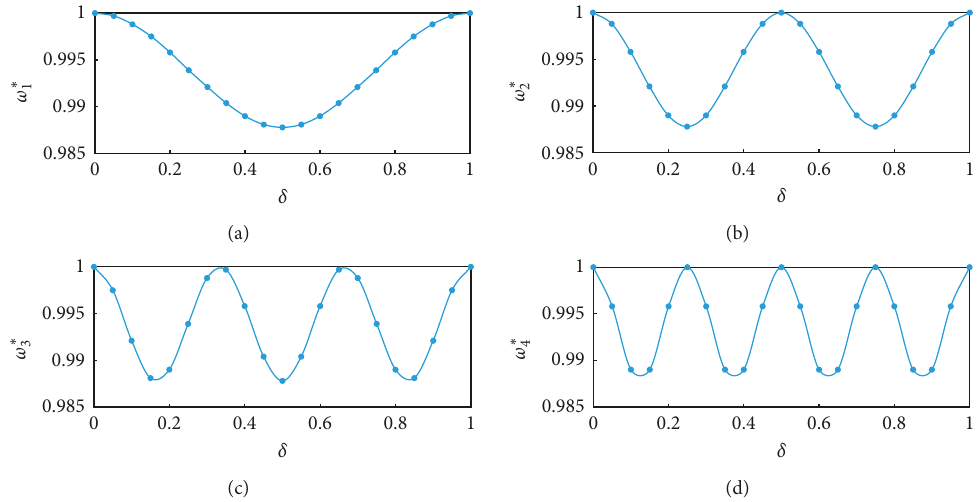
Figure 2: Variations of the first four normalized frequencies in terms of crack position ( δ ) for α